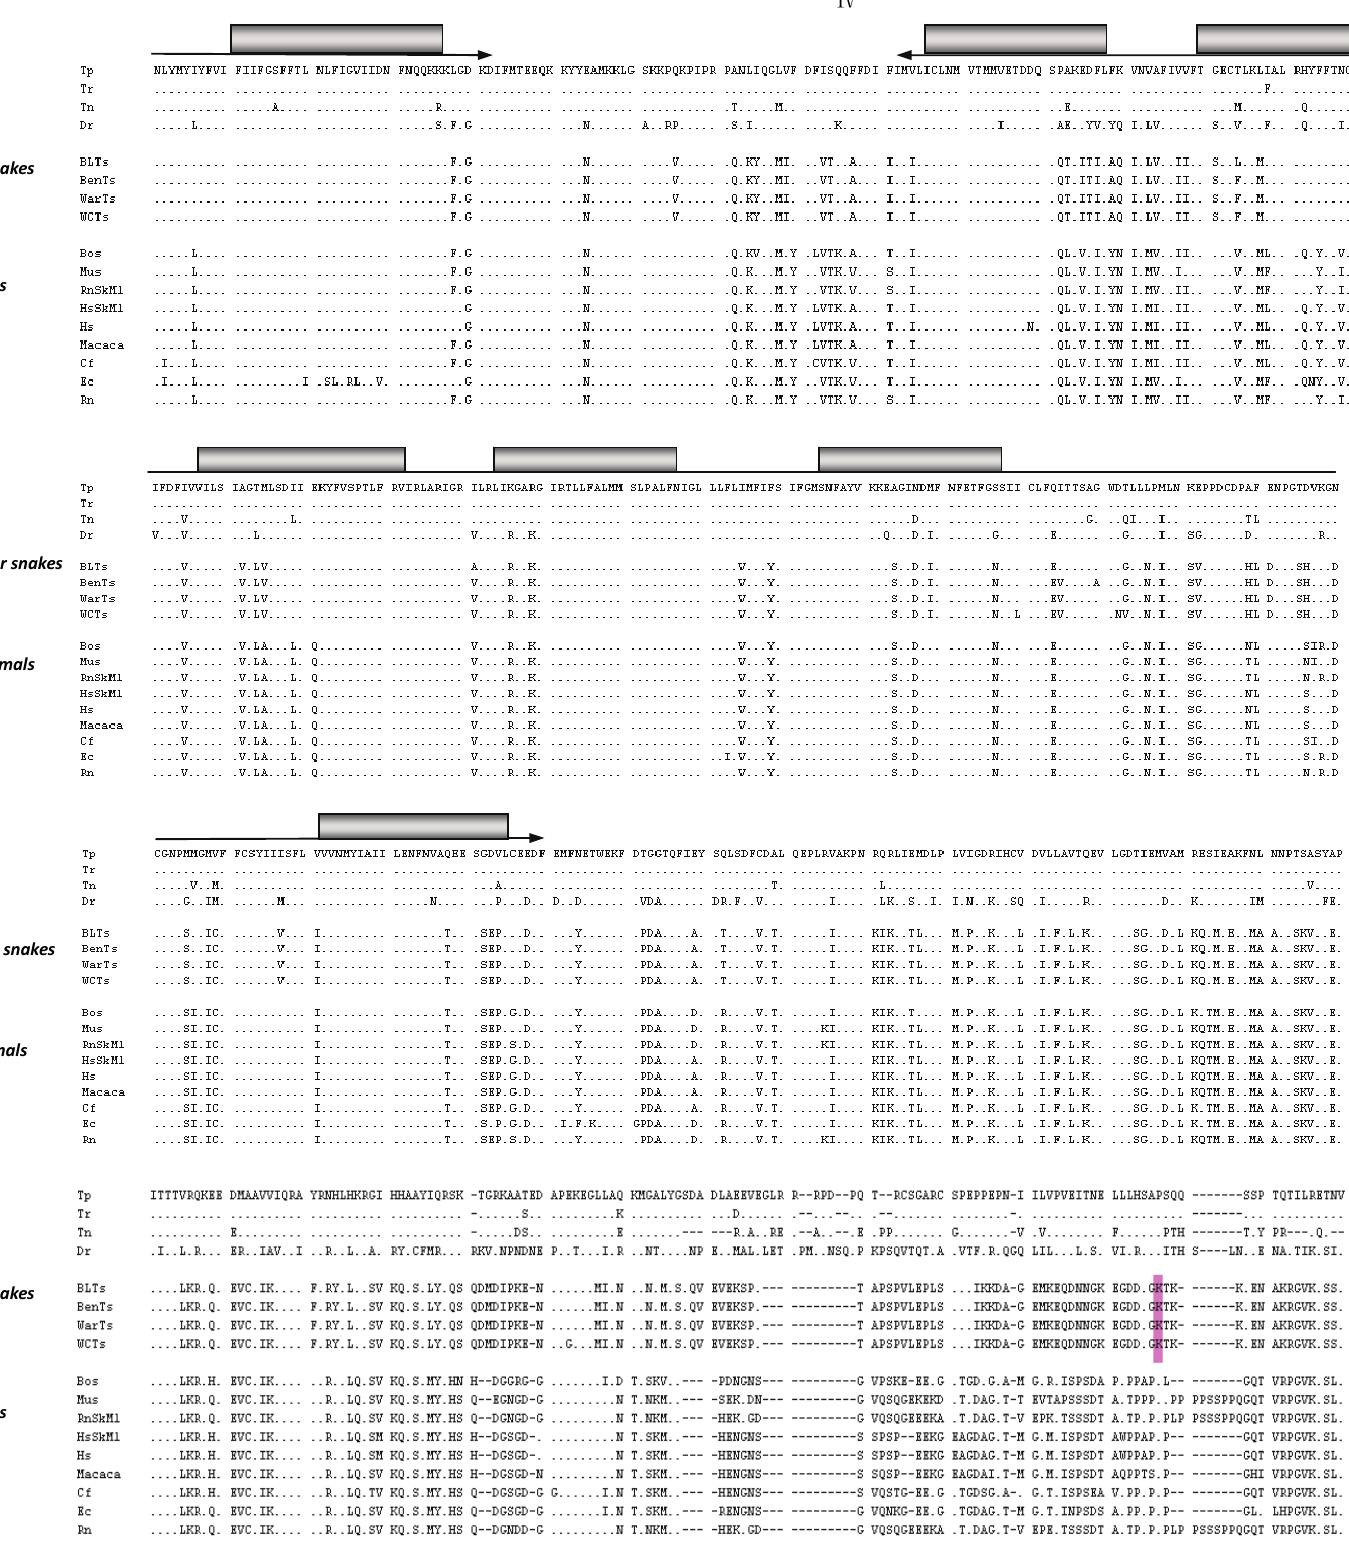
1.4 channels from pufferfish, garter snakes and v